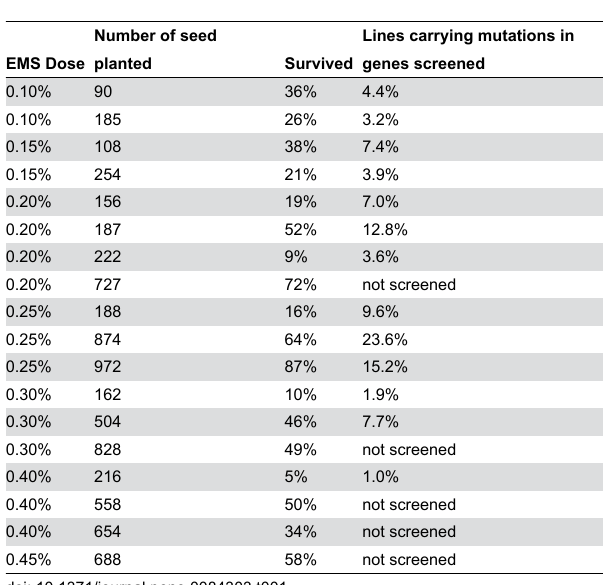
Table 1. Summary of B. napus EMS-mutagenised populations grown for